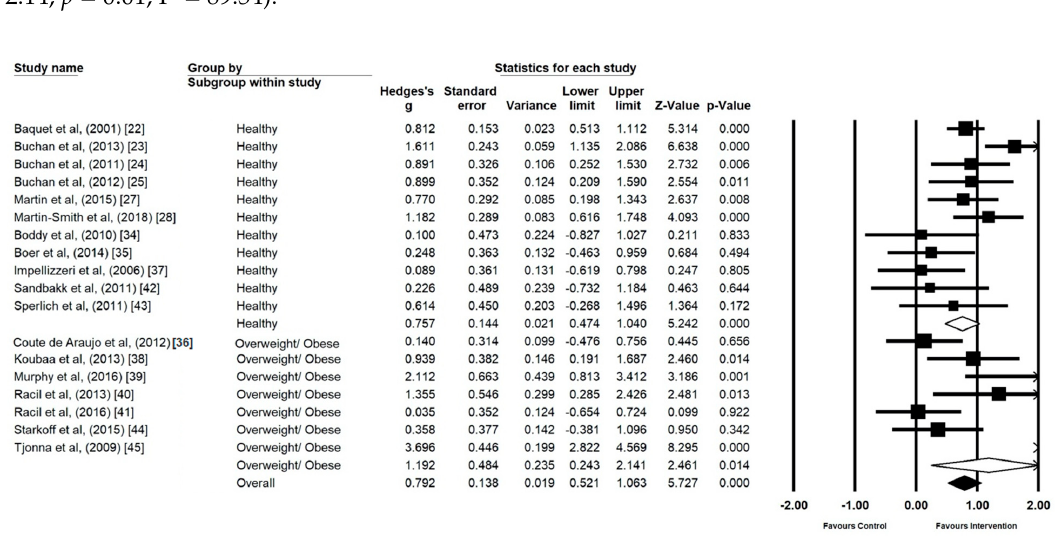
Figure 4. Forest Plot of the Comparison of effect size of high intensity interval training (HIIT) and sprint interval training (SIT) on cardiorespiratory fitness (CRF) in studies using healthy and overweight/obese participants.